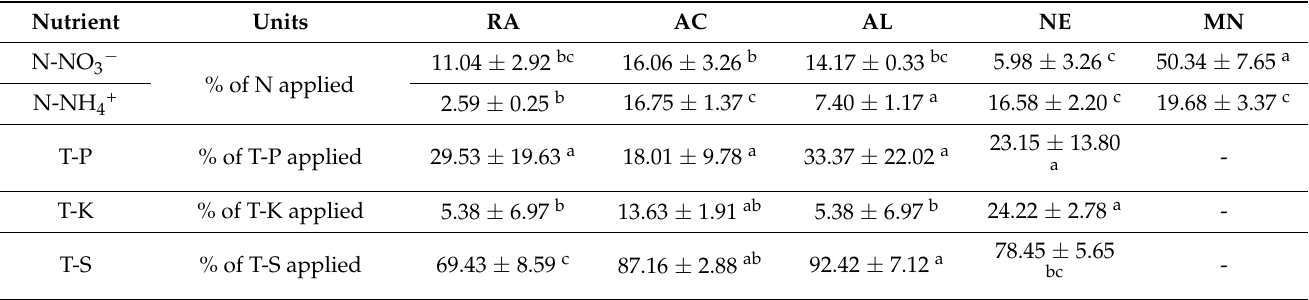
Table 3. Amount of N-NO 3 − , N-NH 4+ , T-P, T-K and T-S lost by leaching over the three IEs in the treatments considered (RA = Raw dairy slurry; AC = Acidified dairy slurry; AL = Alkalinized dairy slurry; NE = Neutralized dairy slurry; MN = Mineral fertilizer), expressed as a percentage of the amount applied (means, n = 4). For each nutrient, values followed by different letters are significantly different based on the Tukey test ( p <